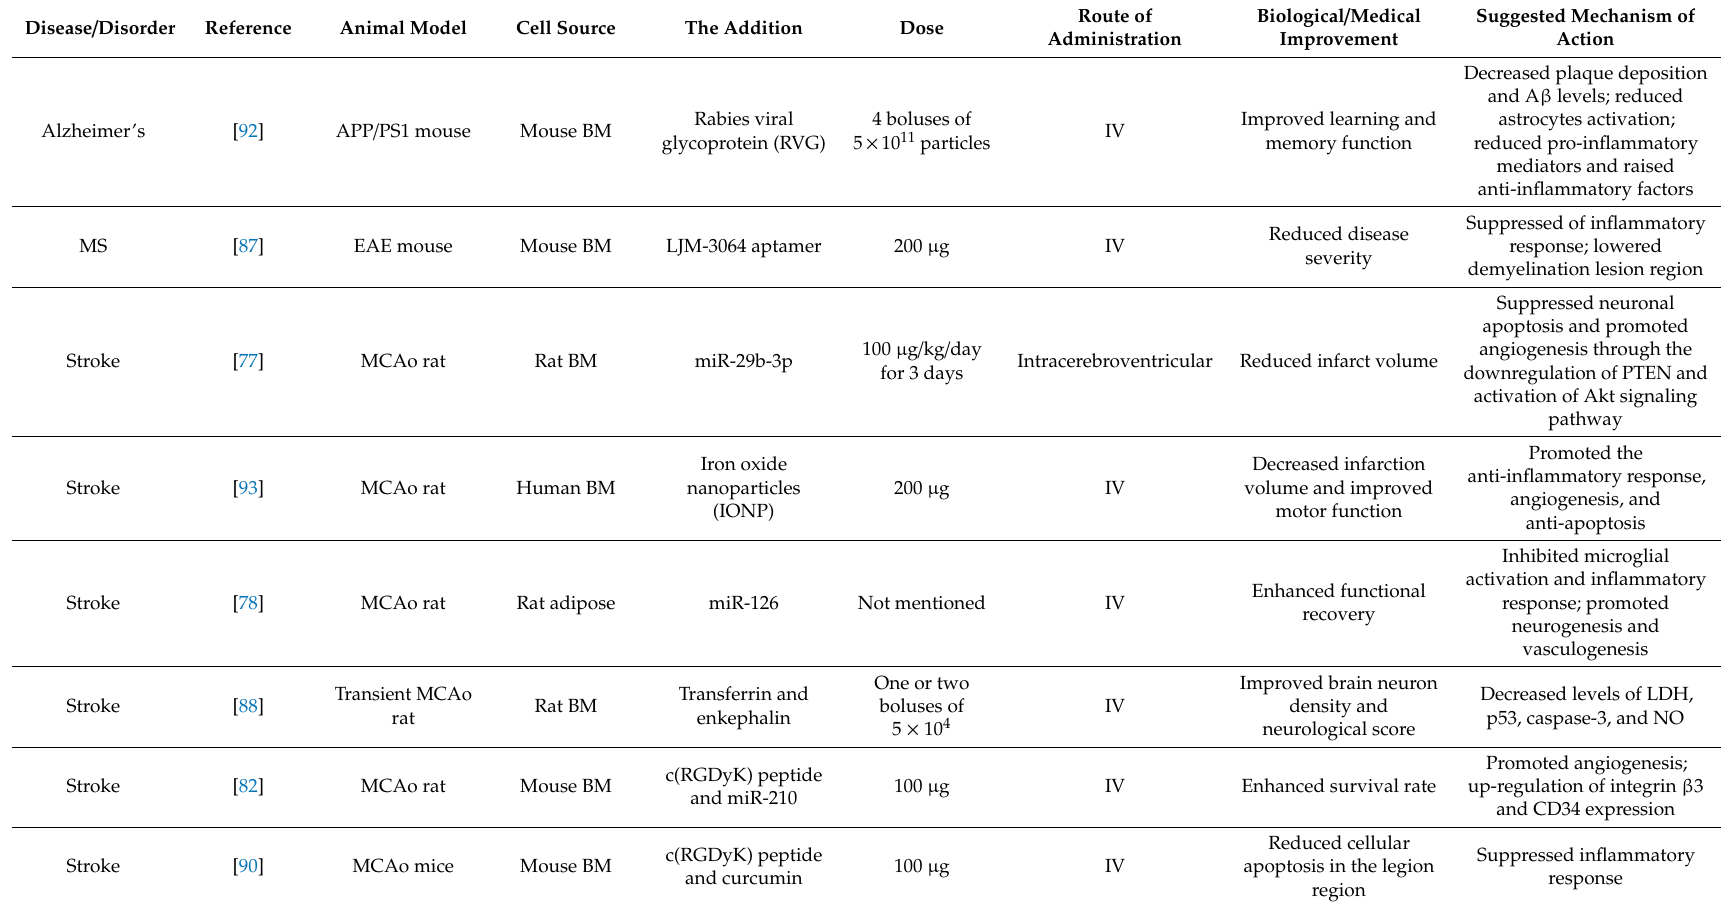
Table 3. Enriched mesenchymal stem cell (MSC)-derived exosomes in animal models of